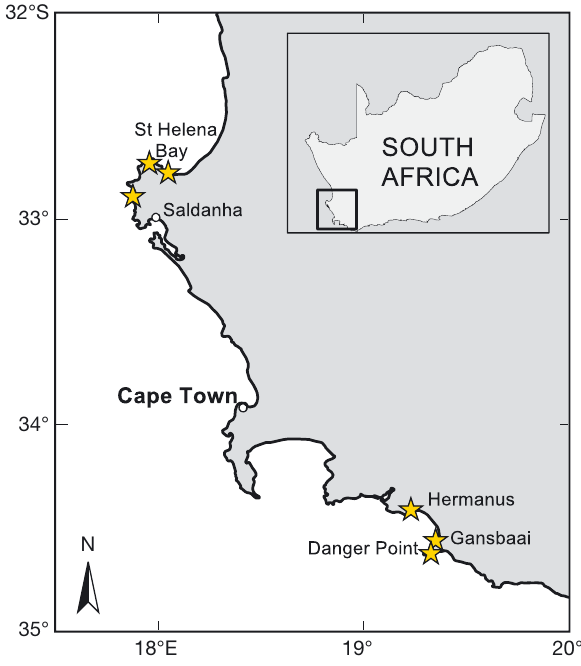
Fig. 1. Location of ‘west coast’ abalone farms near St Helena Bay and ‘south coast’ farms in the Hermanus/Gansbaai area, South Africa. Stars indicate locations of individual farms or clusters of